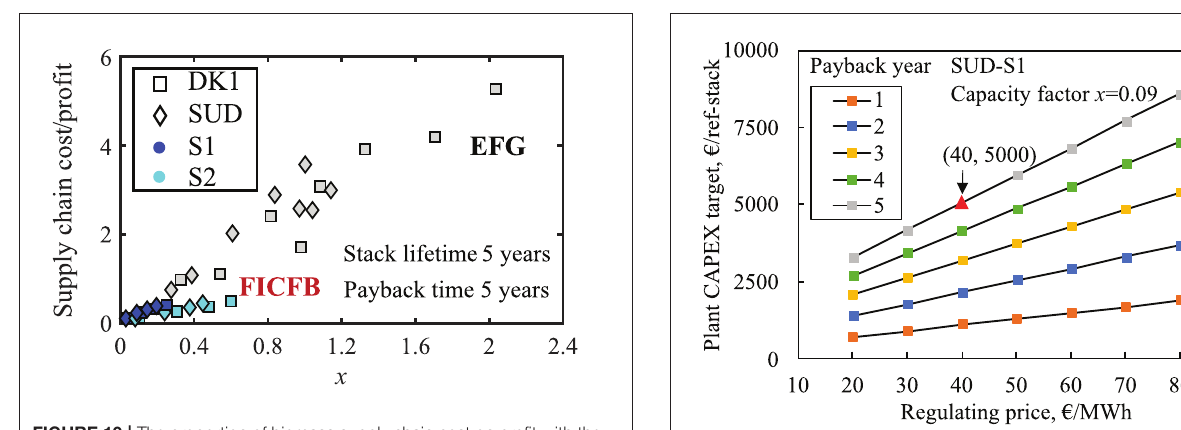
FIGURE 10 | The proportion of biomass supply chain cost on profit with the FICFB-based plant highlighted. presented in Puigjaner (2011), Laínez et al. (2011), and Pérez-